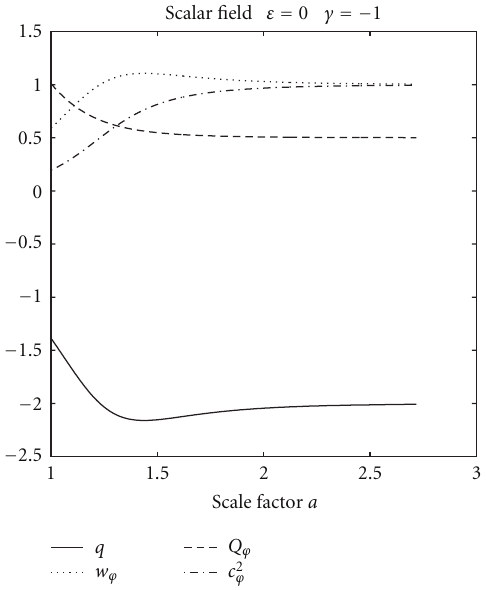
Figure 6: Evolution of the acceleration parameter q versus the scale factor, for γ = − 1 with initial condition satisfying | x i | = 0 . 1 < (cid:12) . The scalar field becomes − 2 / 3 γ . The field starts with an EoS w ϕ only